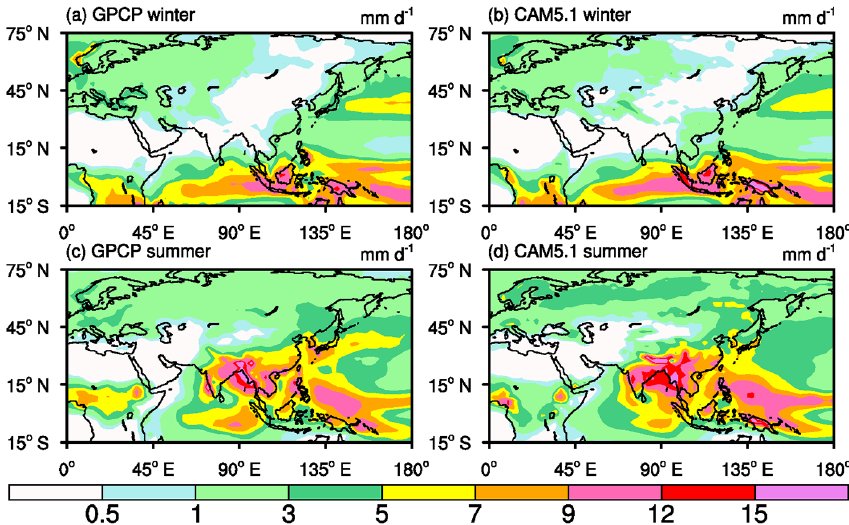
Figure 2. Comparisons between (left) GPCP data and (right) CAM5.1 precipitation simulations during (top) winter and (bottom) summer (10-year averages for